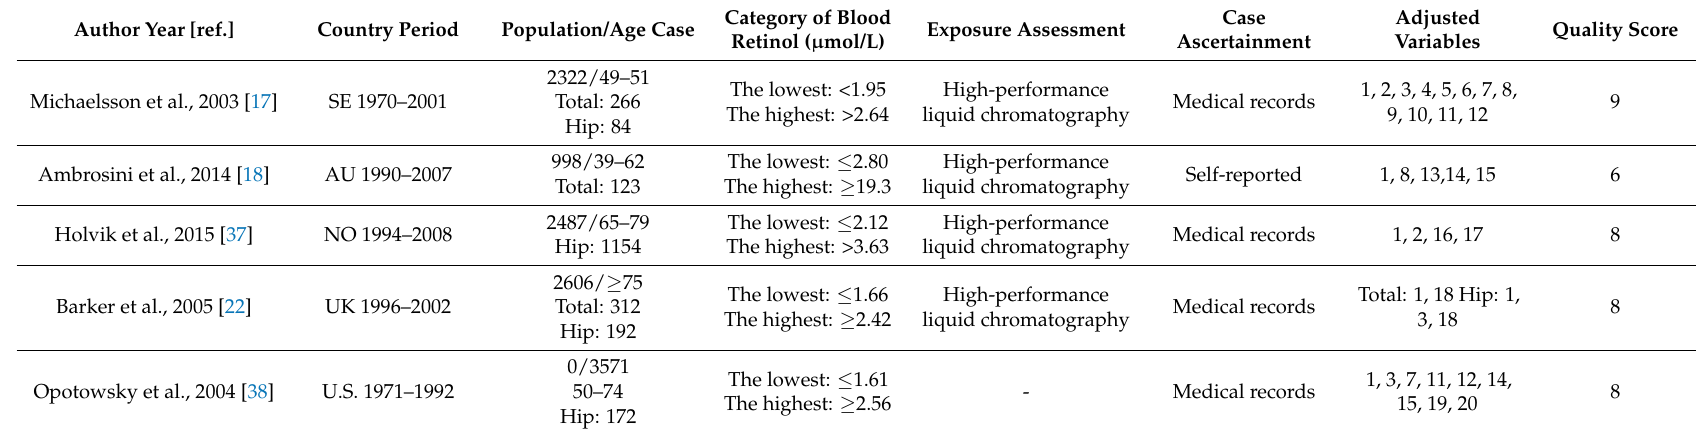
Table 2. Characteristics of studies on blood level of